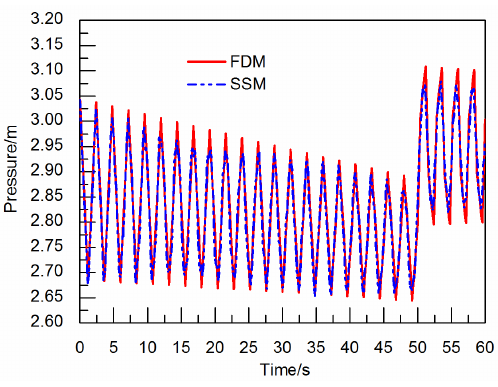
Figure 4. Method verification of pressurized-open flow